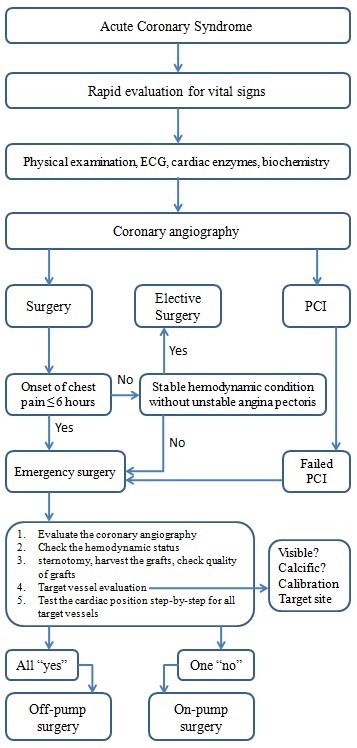
The diagram of off-pump coronary artery bypass surgery selection criteria.